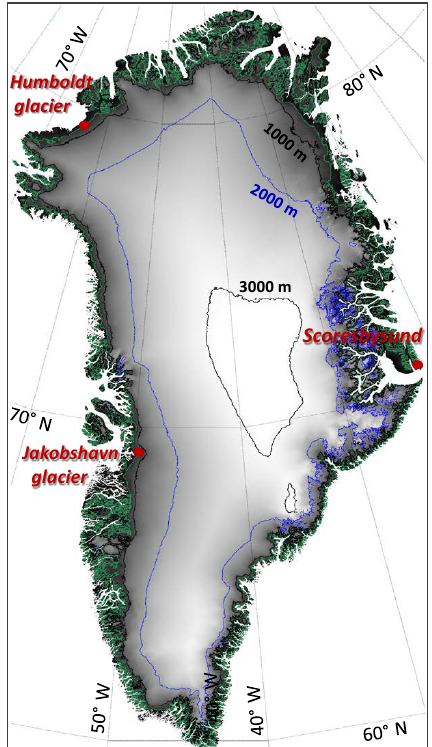
Figure 1. Location and topographic map of the Greenland Ice Sheet with 500m (green), 1000m (black), 2000m (blue) and 3000m (black) contour lines overlaid. Greenland surface elevation from Howat et al. (2014) is displayed, where darker greys indicate lower elevation (minimum at sea level, 0m) and brighter greys and white indicate higher elevation (maximum at